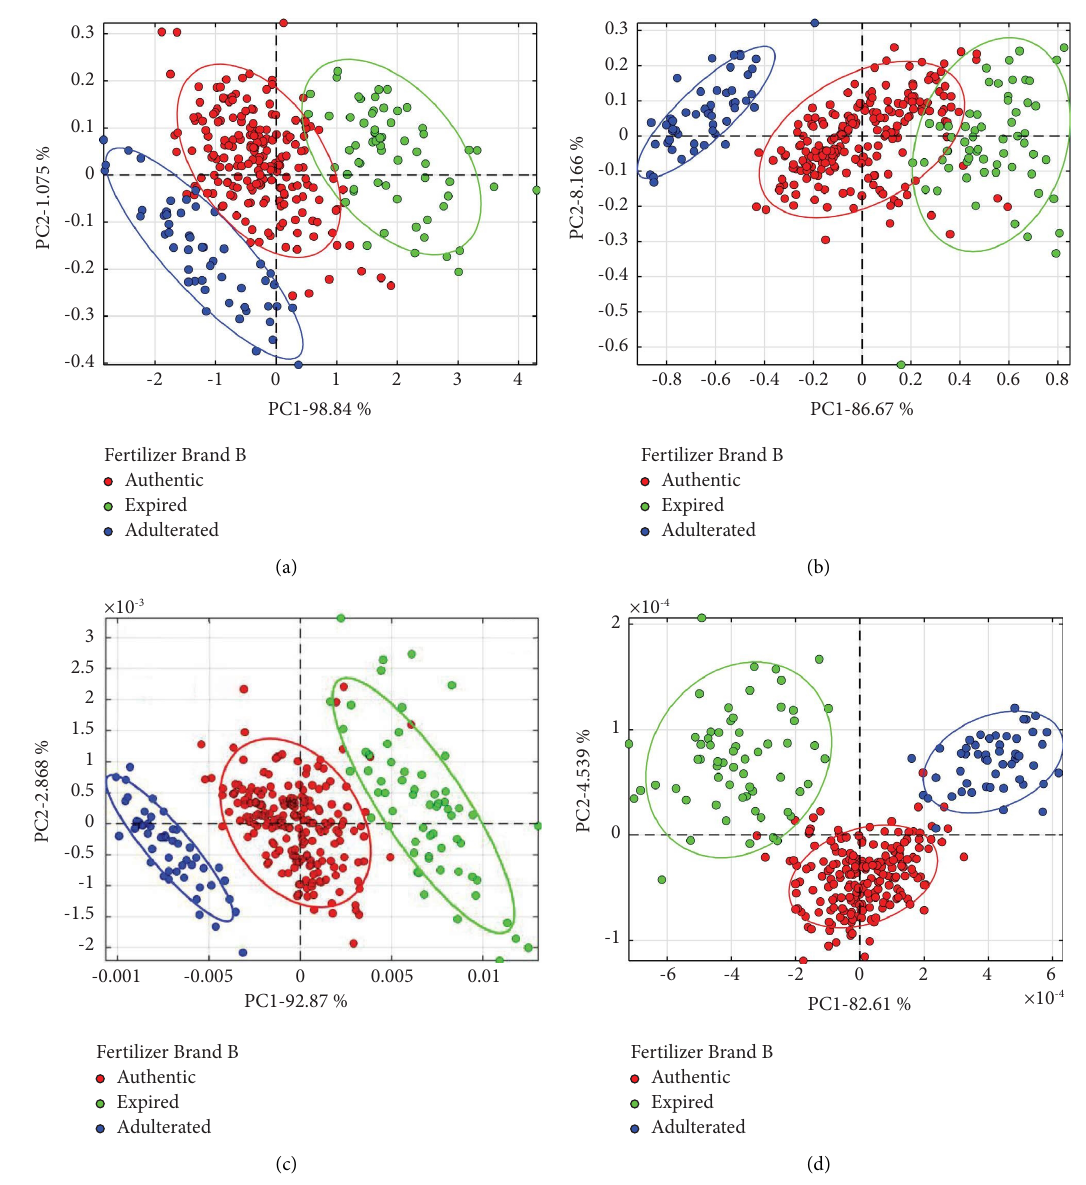
Figure 4: PCA score plot: (a) raw, (b) SNV, (c) SGFD, and (d) SGSD of fertilizer brand B.